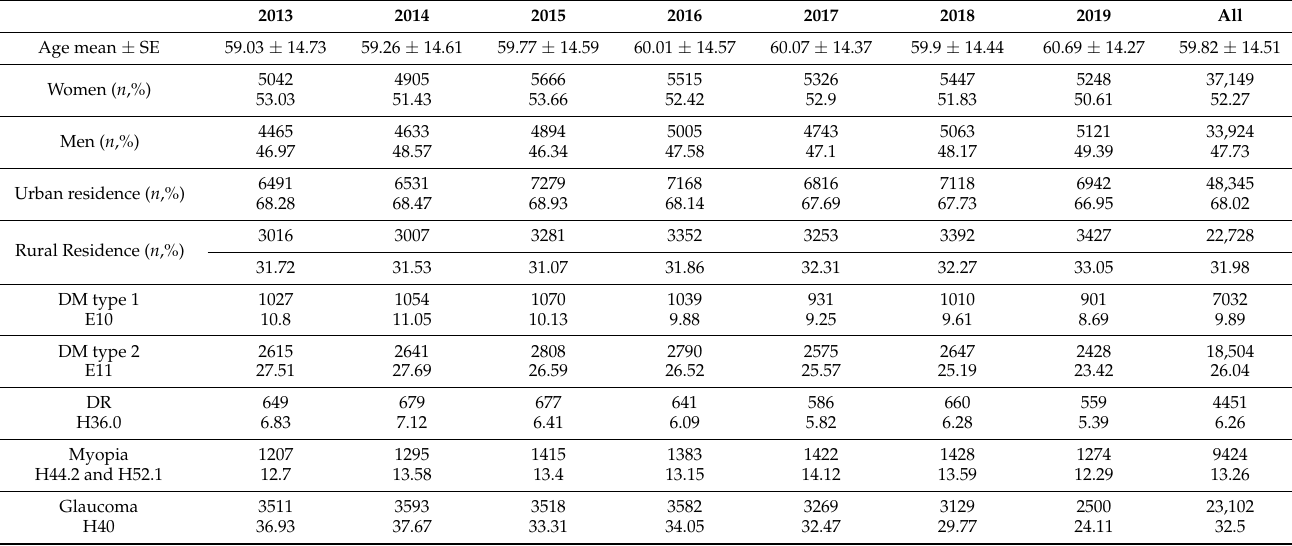
Table 2. The demographic characteristics of patients with RD and comorbid